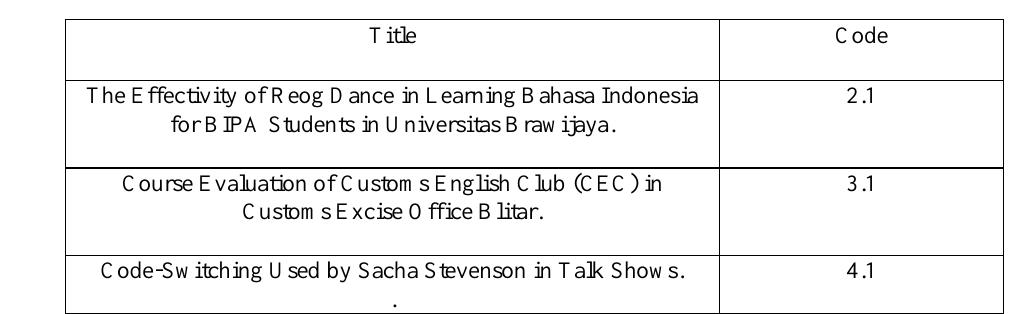
Selected research articles from the Alphabet Title Code Apology Strategies Used by Chad Griffin Addressed to The Lesbian, Gay, Bisexual and Transgender Community Social Media and Its Impact on the Use of English Borrowings in Indonesian Positive-Self and Negative-Other Representation in the Online News Behind Indonesia’s Anti-Chinese Riots and Indonesia Turns Its Chinese into Scapegoats The concept of Kami on Japanese Web 2011 Corpus 1.4